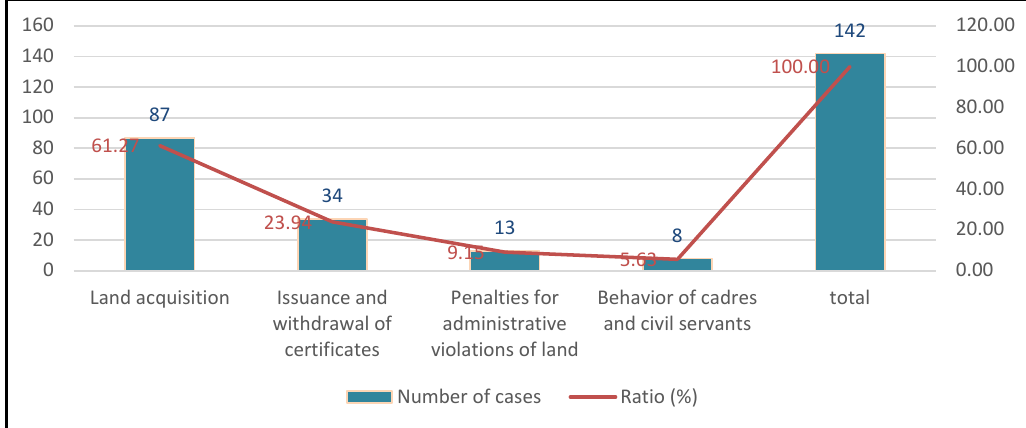
Fig. 4. Types of land complaints in Bac Ninh city in the 2016-2020